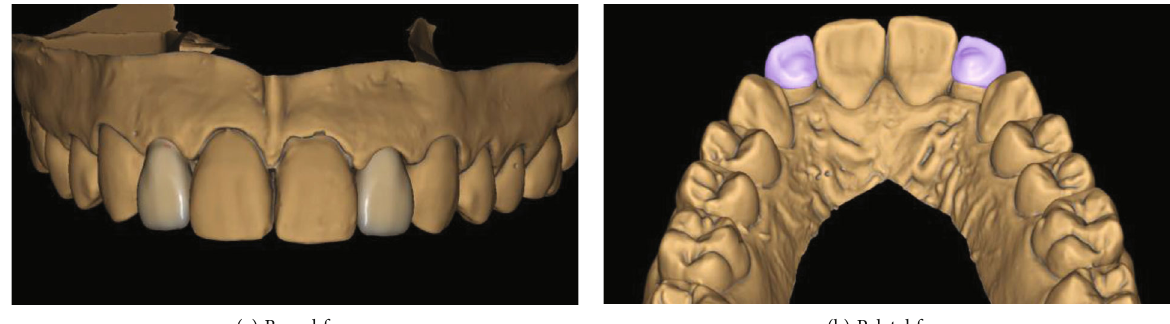
Figure 6: Virtual three-quarter crowns conceptioned by Exocad Software